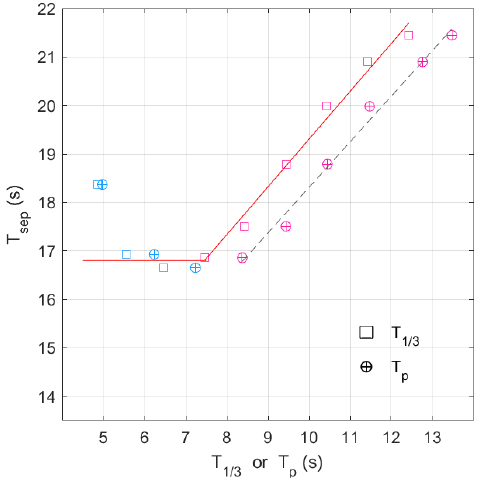
Figure 4. Plots of 𝑇 (cid:3043) and the representative 𝑇 (cid:2869)/(cid:2871) as a function of 𝑇 (cid:3046)(cid:3032)(cid:3043) with the linear regression lines for the range of 𝑇 1/3 > 7.5